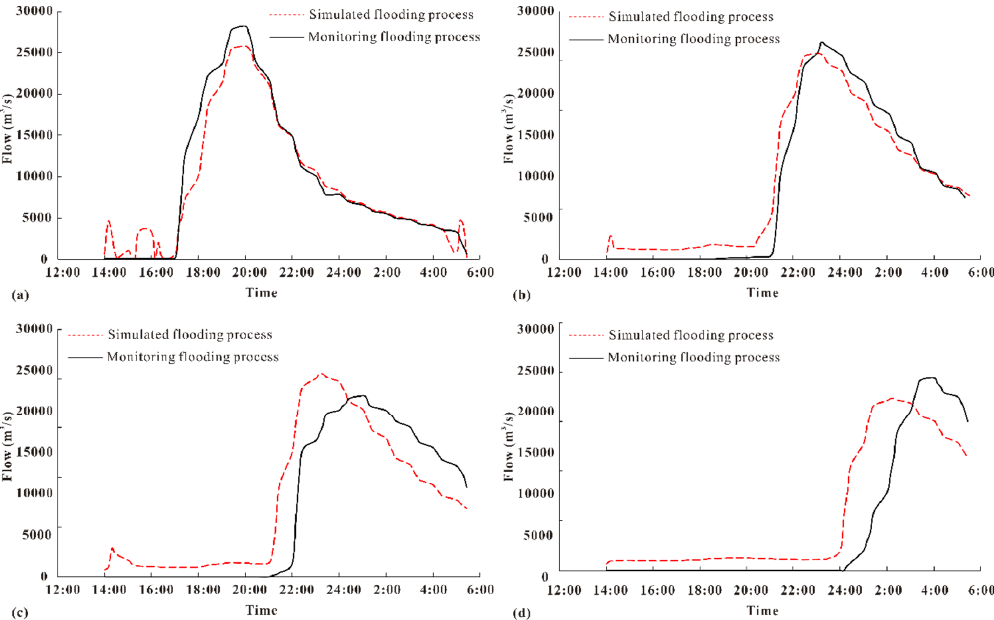
Figure 5. Actual outburst flood process curves and numerical simulation of flood process curves: ( a ) outburst flood curves at the Yebatan arch dam; ( b ) outburst flood curves at the Lawa hydropower station; ( c ) outburst flood curves at the Batang hydropower station; ( d ) outburst flood curves at the Suwalong hydropower station.